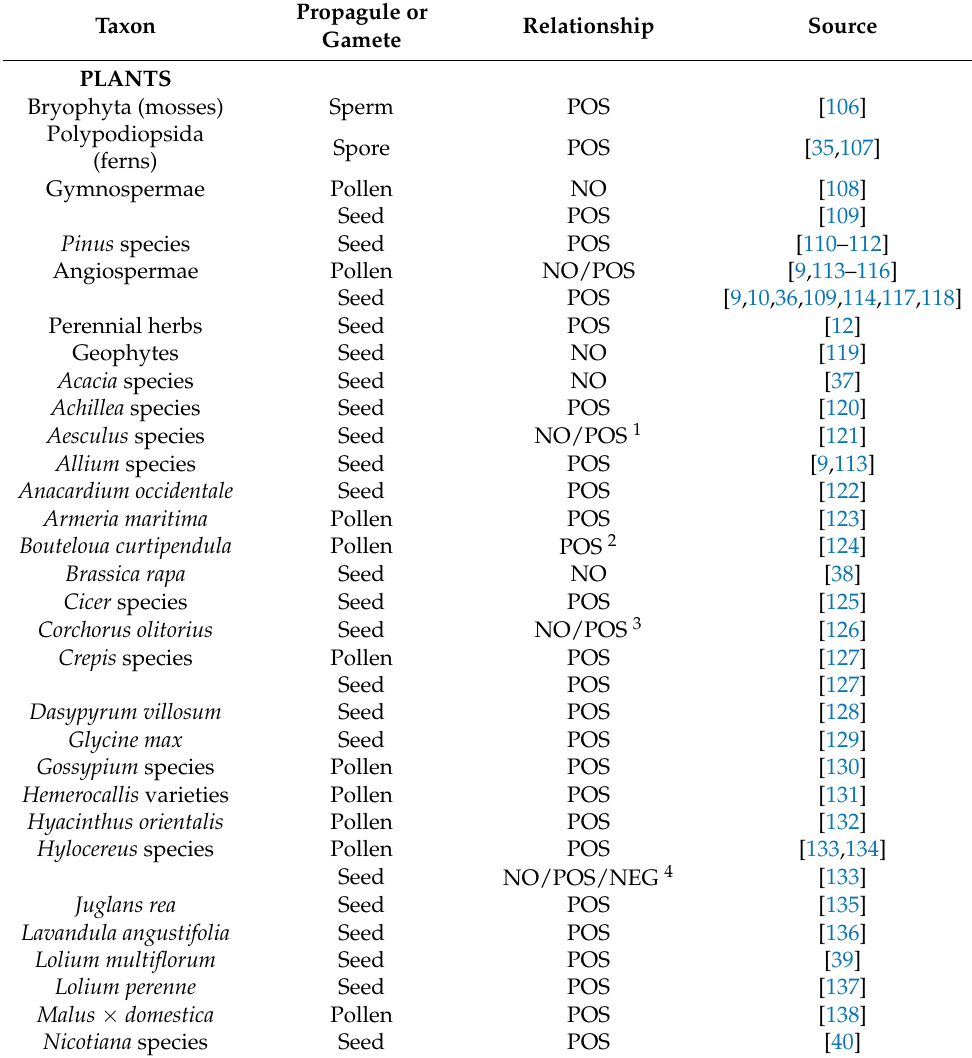
Table 5. Positive (POS), negative (NEG) or nonsignificant (NO) relationships between genome size and propagule or gamete size in various taxa of multicellular organisms. Propagule or Taxon Gamete